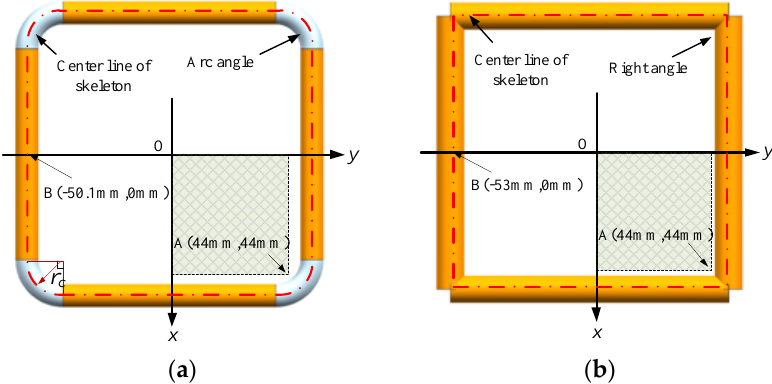
Figure 18. Skeletons with circular cross-section of the Rogowski coil. ( a ) Skeleton with arc angle; ( b )